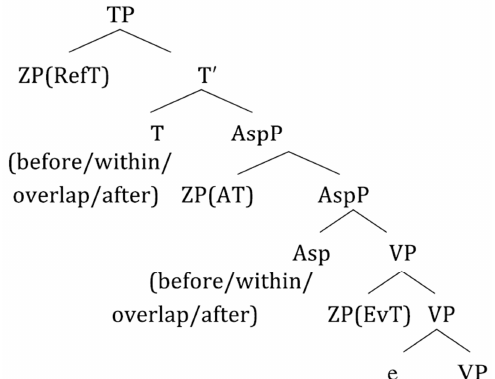
Figure 1. The structural derivation of viewpoint aspect (Arche 2014, p. 796; Demirdache and Uribe-Extebarria 2000, p. 163).